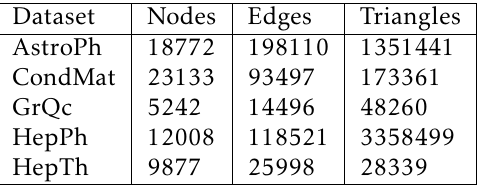
Table 6. Stats of Five More Datasets Dataset